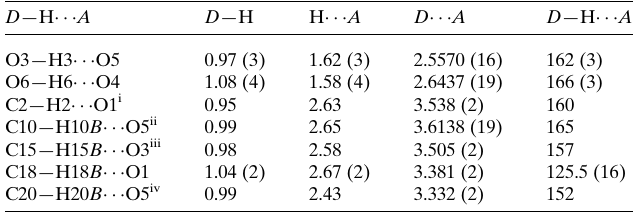
Table 1 Hydrogen-bond geometry (A˚ , (cid:3) ) for (I).